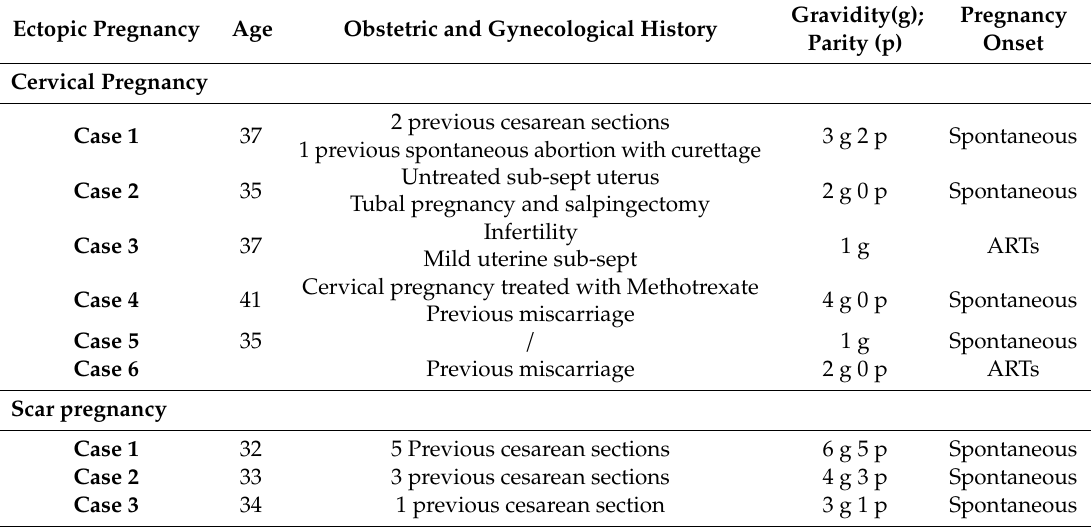
Table 1. Demographic characteristics, obstetric and gynecological history and ectopic pregnancy risk factors in the study